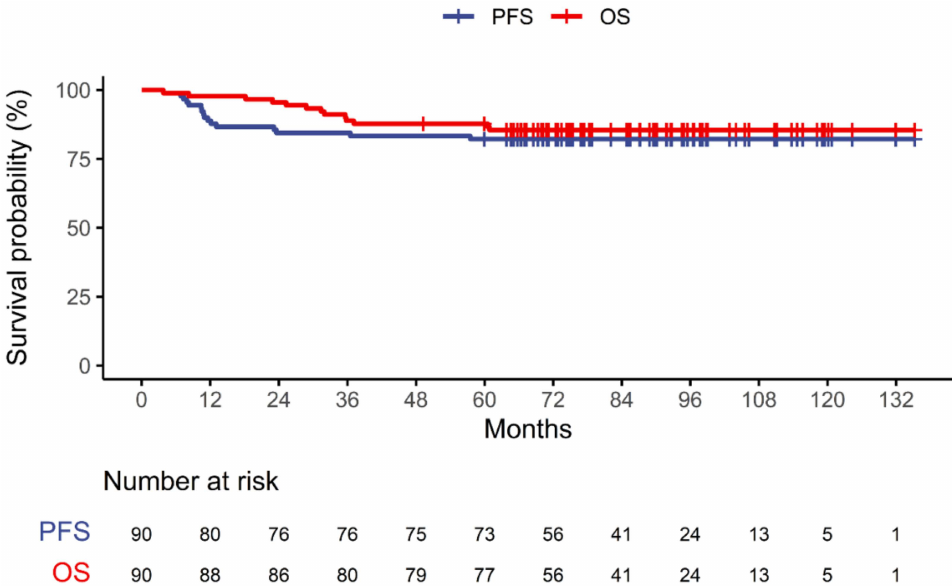
Figure 1. Progression-free survival (PFS) and overall survival (OS) during the follow-up period. Tick marks represent censored data.